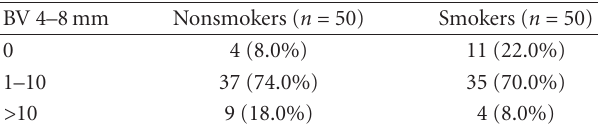
Table 12: Comparison of BV diameter 4–8mm between nonsmok- ers and smokers.